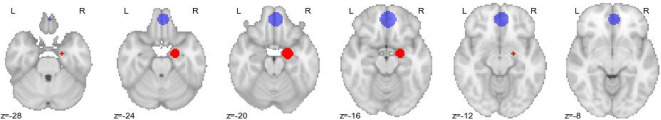
Graphical depiction of the regions-of-interest for the Dynamic Causal Modeling (DCM) analysis. Medial prefrontal cortex (mPFC; blue; peak voxel at MNI coordinates 2, 46, −16) and right amygdala (red; peak voxel at MNI coordinates 20, −6, −20) are shown on axial slices. As the center of the sphere, we used the peak voxels of the group-level activation map. Numbers indicate the MNI z-coordinate.